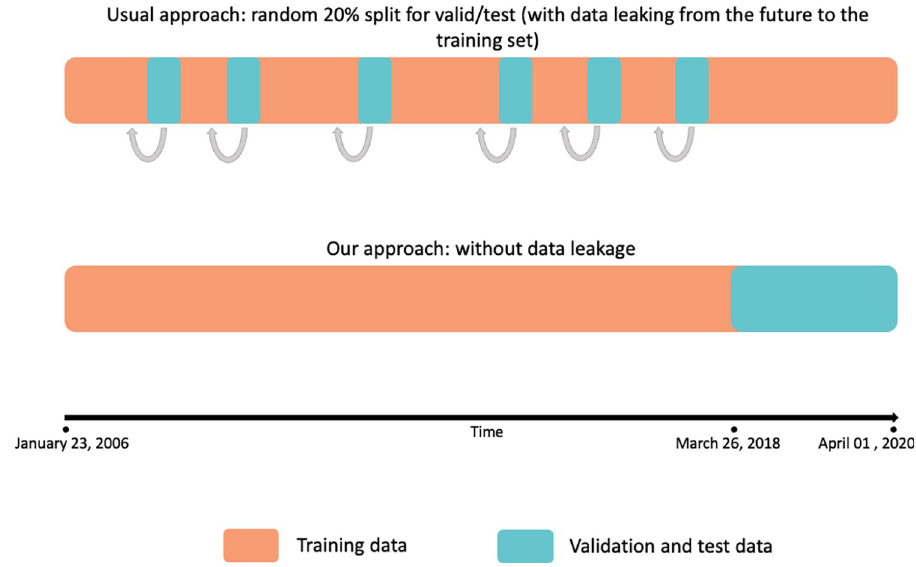
Fig 2. Comparison between traditional holdout method and our time-sensitive approach. Grey arrows show how, in the traditional holdout method, data leaks from the training set into the validation and test sets, which leads to overly optimistic results, as the model has access to information from the